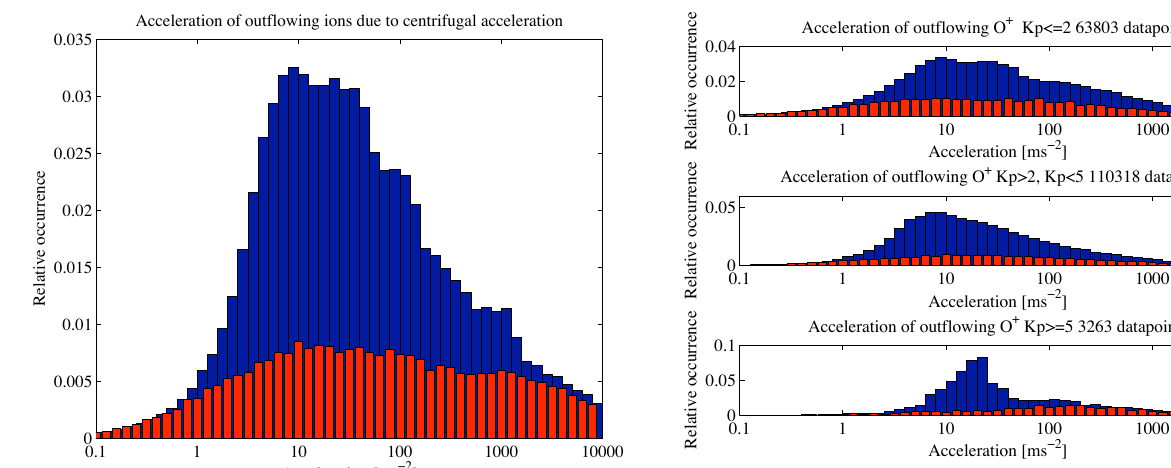
Fig. 3. Distribution of the total centrifugal acceleration for all valid measurement points in the statistical study. The combined data set was used, i.e. H + data was used when no valid O + was available. The x-axis shows the acceleration [ ms − 2 ] , the y-axis shows the relative occurrence for positive (increased outflow velocity, blue bars) and negative acceleration (decreased outflow velocity, red bars). The red bars are shifted half a bin towards lower values to increase readability.